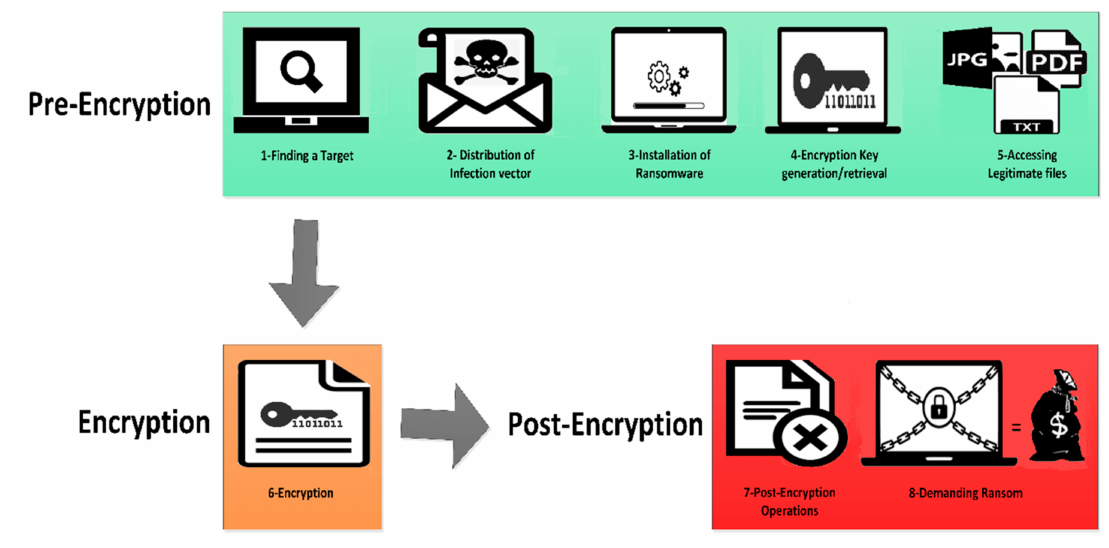
Figure 2. Ransomware attack